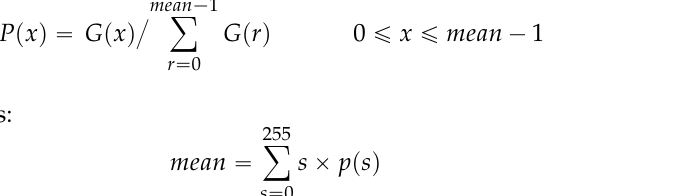
Figure 6. DRE results for Daniel image, ( a ) Dark region of the GVR image; ( b ) DRE image; ( c ) DRE histogram.